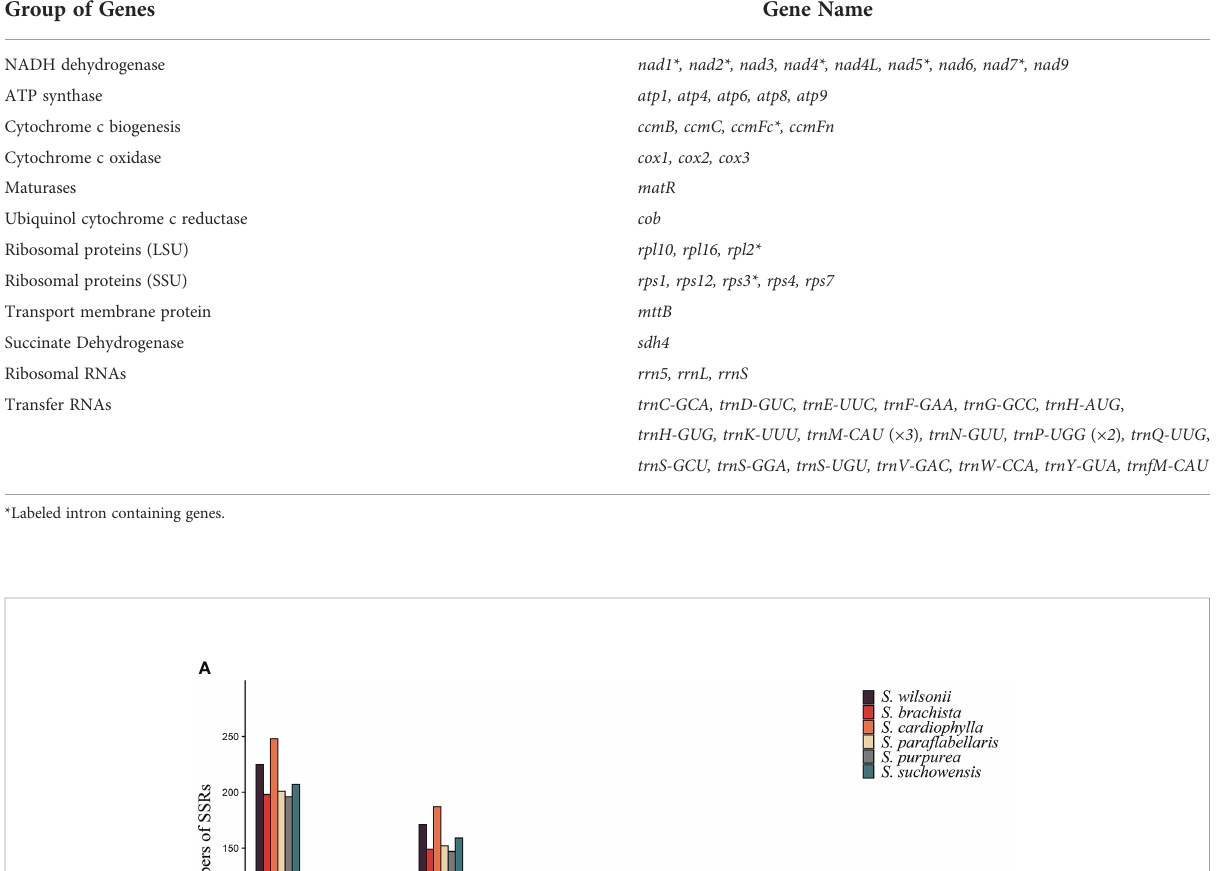
TABLE 2 Gene composition of the S. wilsonii mitogenome.